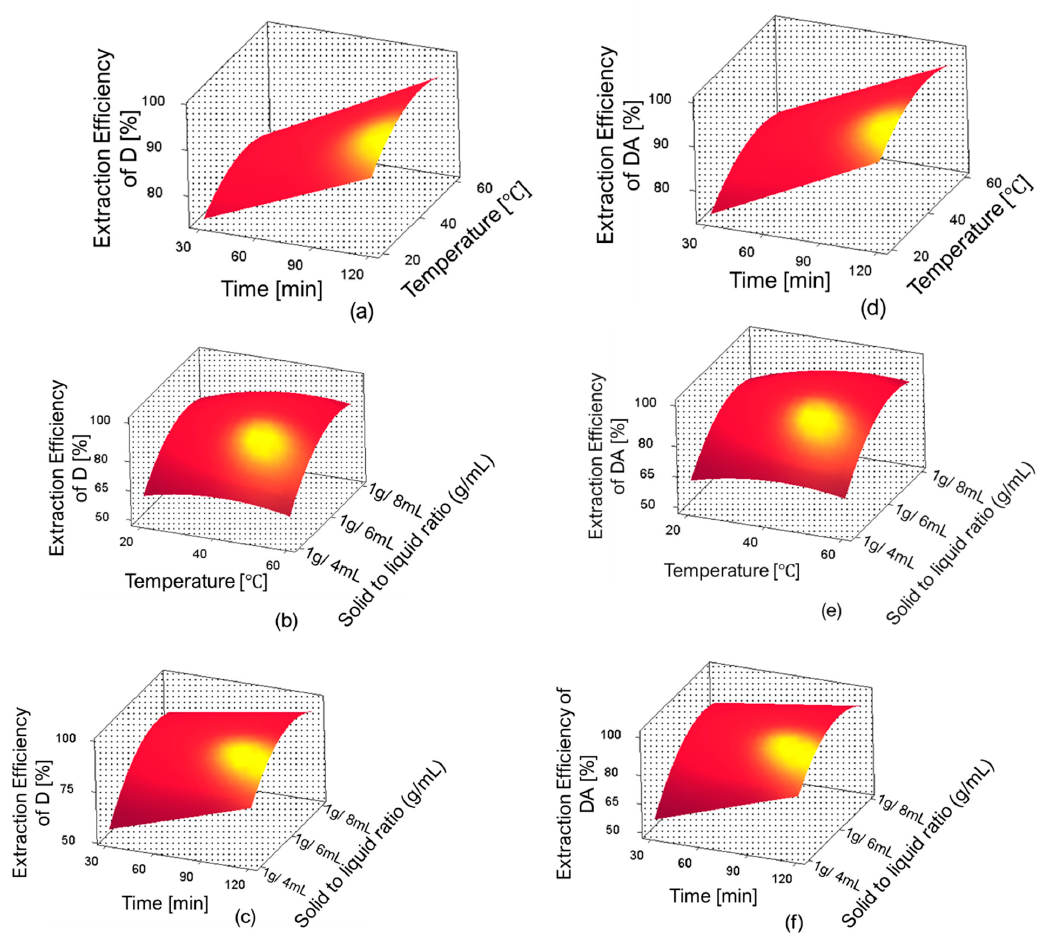
Figure 7. Response surface plots showing the interaction between single factors on the extraction efficiencies of D and DA. ( a ) effect of time and temperature on extraction efficiency of D, ( b ) effect of temperature and solid-to-liquid ratio on extraction efficiency of D, ( c ) effect of time and solid-to-liquid ratio on extraction efficiency of D, ( d ) effect of time and temperature on extraction efficiency of DA, ( e ) effect of temperature and solid-to-liquid ratio on extraction efficiency of DA and ( f ) effect of time and solid-to-liquid ratio on extraction efficiency of DA.